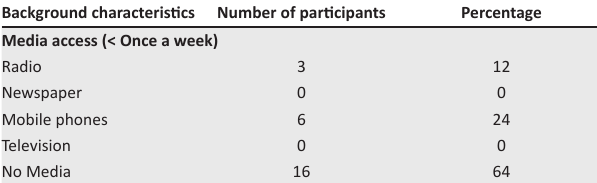
TABLE 6: Pregnant women ’ s access to information media.